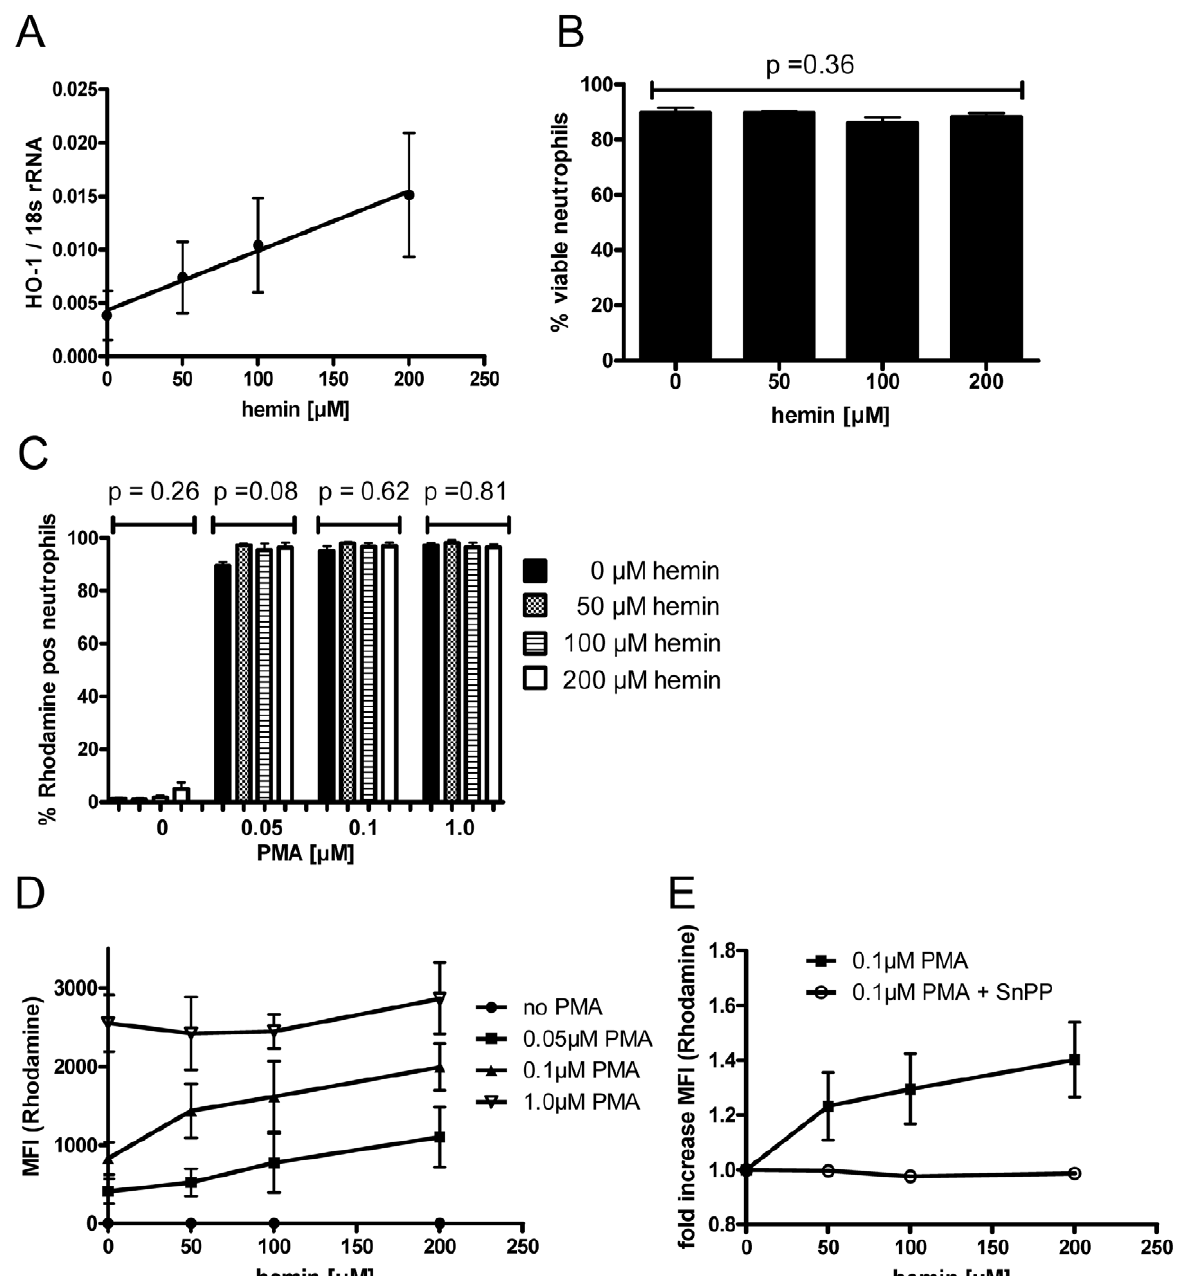
Figure 4. Hemin-induced HMOX1 induction primes the oxidative burst of neutrophils. In 8 independent experiments, whole blood from different donors was incubated for 18 hours with increasing amounts of hemin in the presence or absence of 10 m M SnPP and the neutrophil oxidative burst induced by PMA was quantified by flow cytometric assessment of oxidation of dihydrorhodamine 123 into the fluorescent rhodamine. A) HMOX1 mRNA levels induced by various concentrations of hemin. B) Viability of neutrophils after 18 hrs pre-incubation with 0–200 m M hemin. C) Proportion of neutrophils that mount an oxidative burst, defined as positive rhodamine fluorescence. D) Magnitude of the oxidative burst in neutrophils in response to stimulation with 0–1 m M PMA after 18 hrs pre-incubation with 0–200 m M hemin. E) Magnitude of the oxidative burst in neutrophils in response to 0.1 m M PMA after 18 hrs pre-incubation with 0–200 m M hemin with or without addition of 10 m M SnPP. The mean and SE are shown. MFI: median fluorescence intensity.